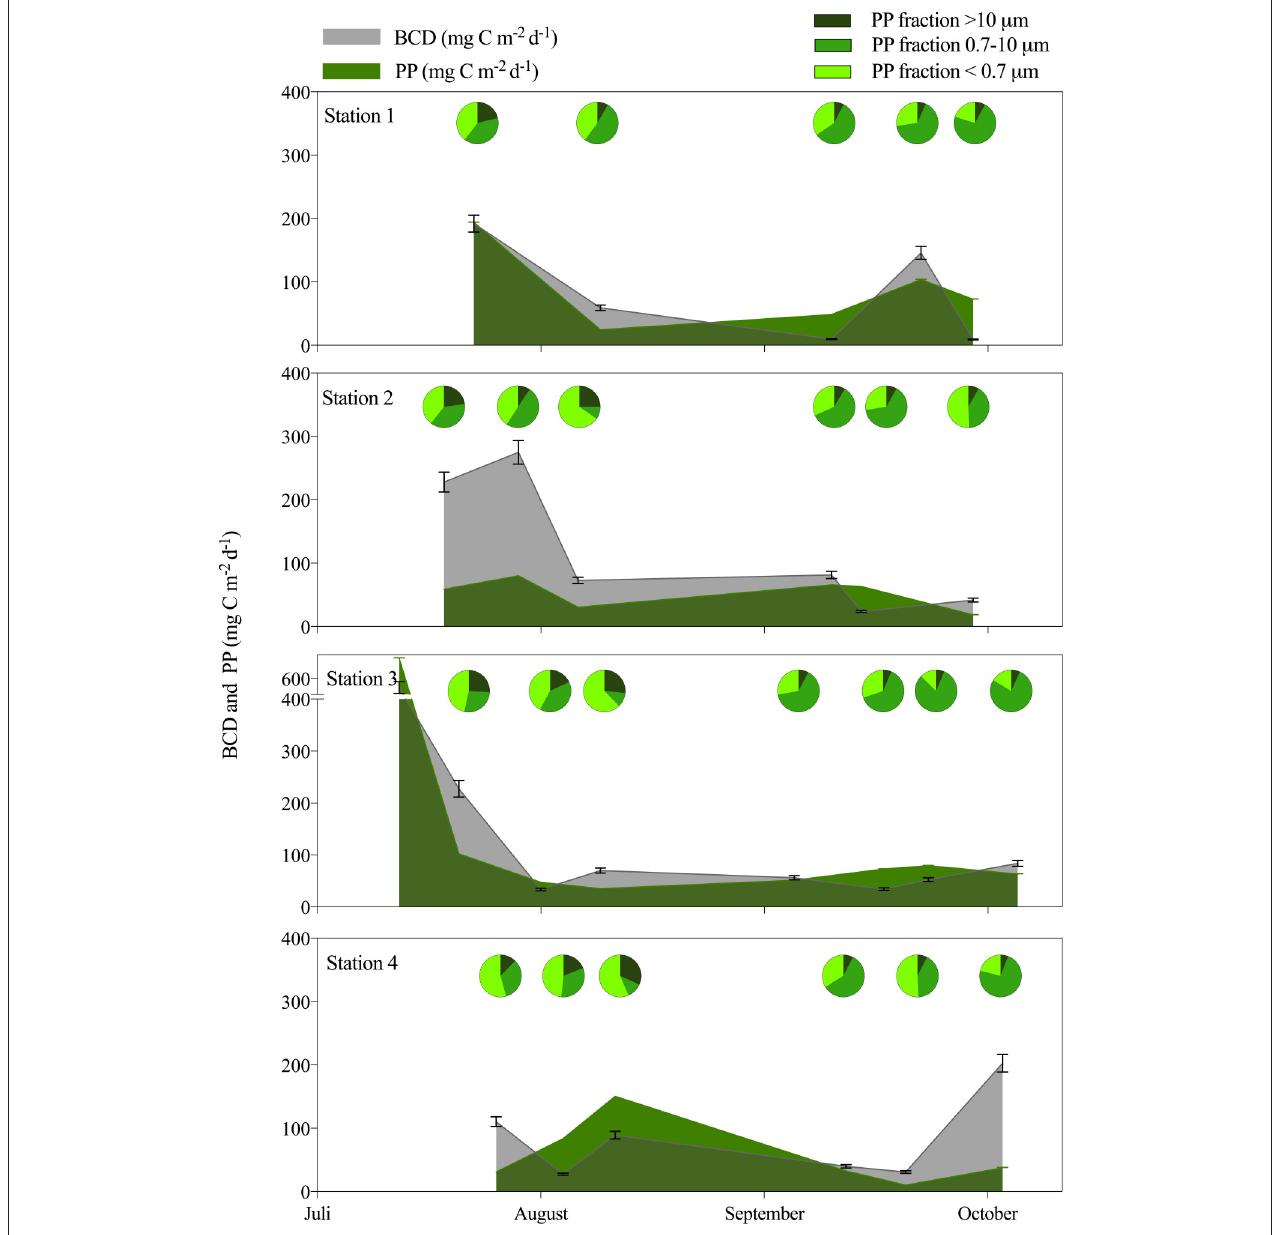
FIGURE 5 | Colored areas show the bacterial carbon demand (BCD) in gray and primary production (PP) in green both integrated over the photic zone (mg C m − 2 d − 1 ) for each of the 4 stations from July to October. The pie diagrams illustrate the contribution of different size fractions of PP averaged for the 1m and DCM sample.